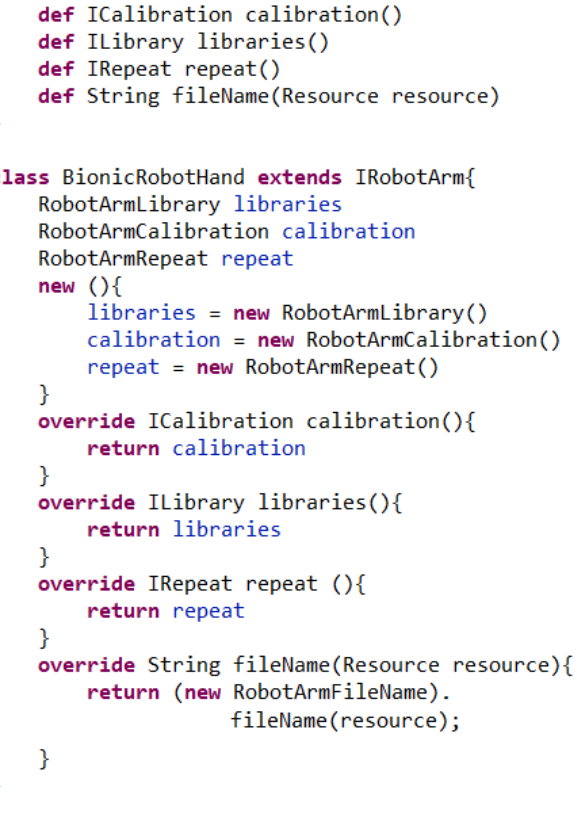
Figure 7. Top level implementation of Bionic rehabilitation hand code